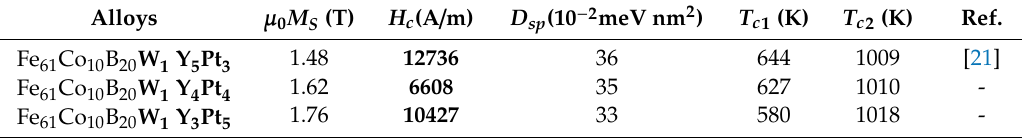
Table 3. Data from analysis of the static hysteresis loops (VSM) and application of the Faraday balance (Figures 7 and 9), where µ 0 M S —saturation magnetisation, H c —coercivity, D sp —spin-wave sti ff ness parameter, T c 1 —Curie temperature for amorphous phase, and T c 2 —Curie temperature for Fe 2 B